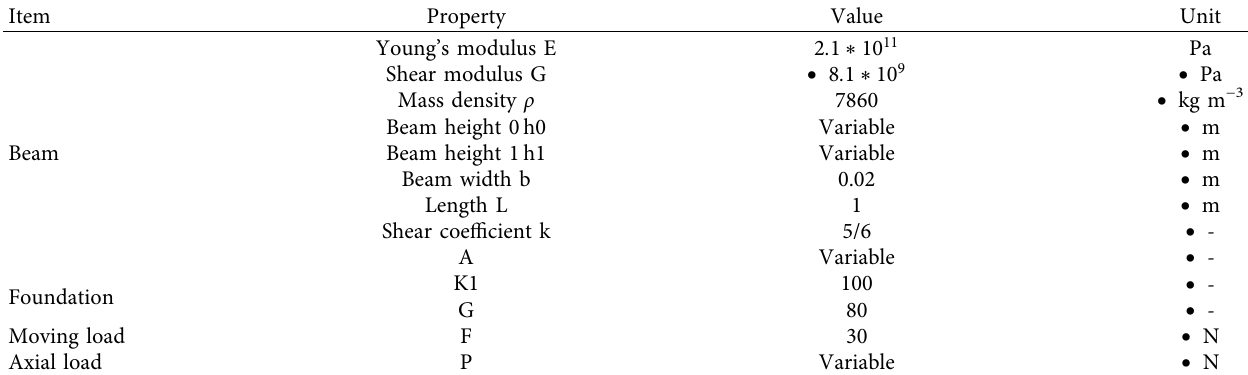
Table 3: Actual governing properties.